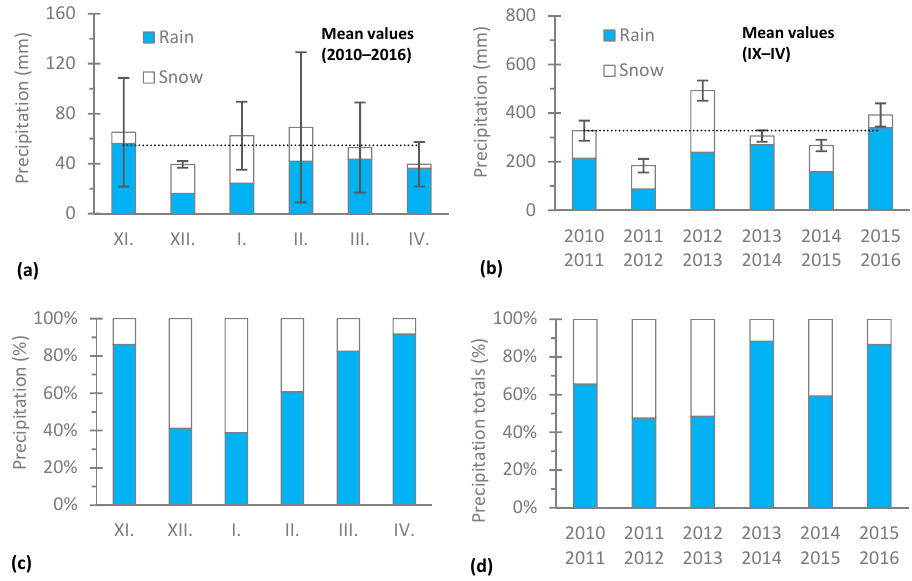
Figure 4. Mean ( a ) monthly and ( b ) seasonal precipitation totals in the solid (snow) and liquid (rain) states at Košútka Ski Centre. The standard error bars of the means were calculated from the precipitation totals. The horizontal dotted lines indicate the mean of the displayed values. The percentage component bar charts show the percentage from the mean ( c ) monthly or ( d ) seasonal precipitation totals (charts above).